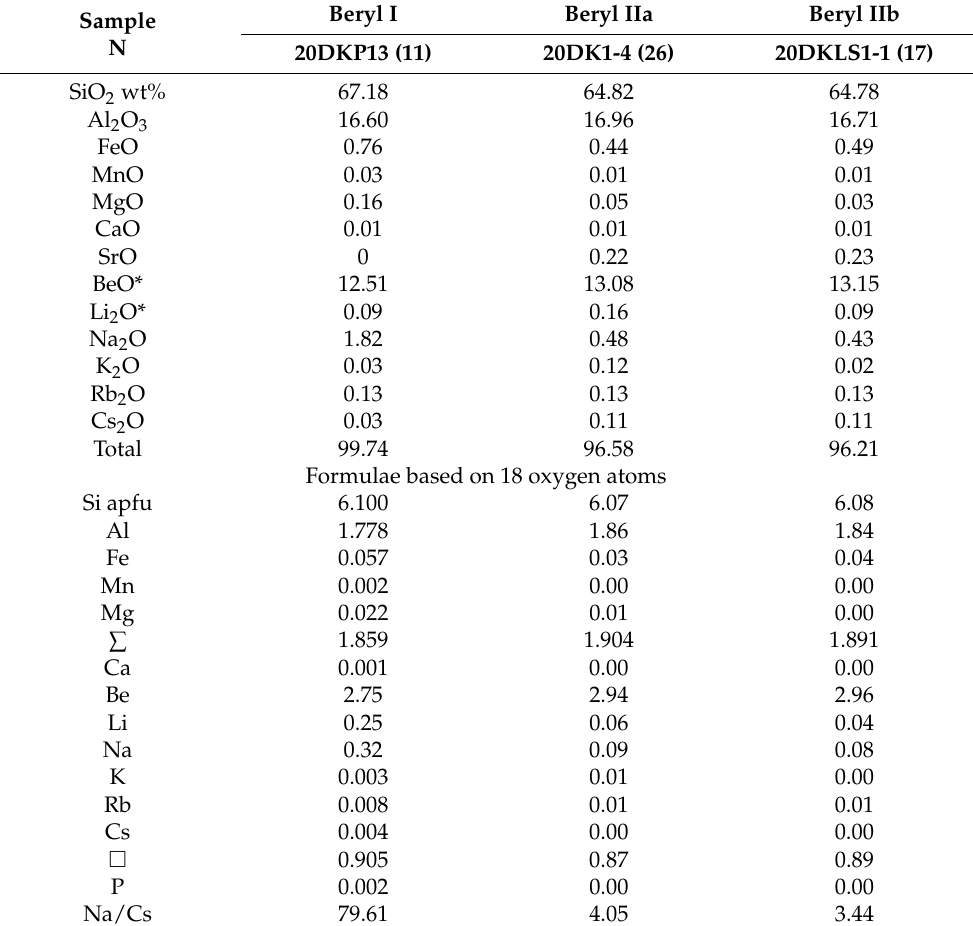
Table 1. The representative EMPA results of beryl in the Dakalasu No.1